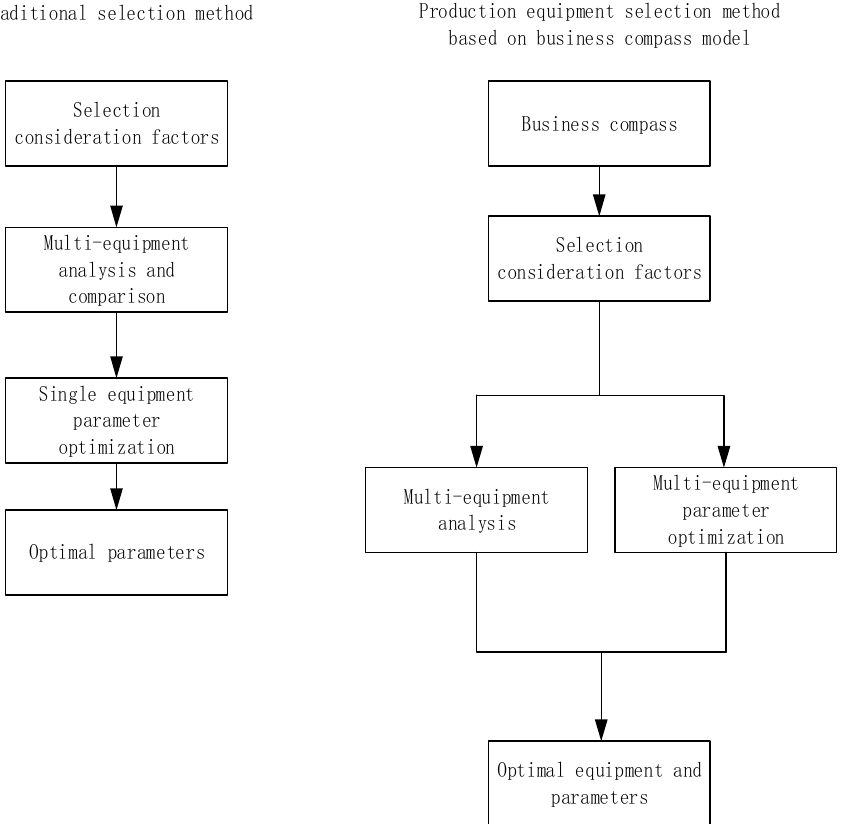
Figure 9. Comparison between traditional equipment selection method and production equipment selection method based on business compass.